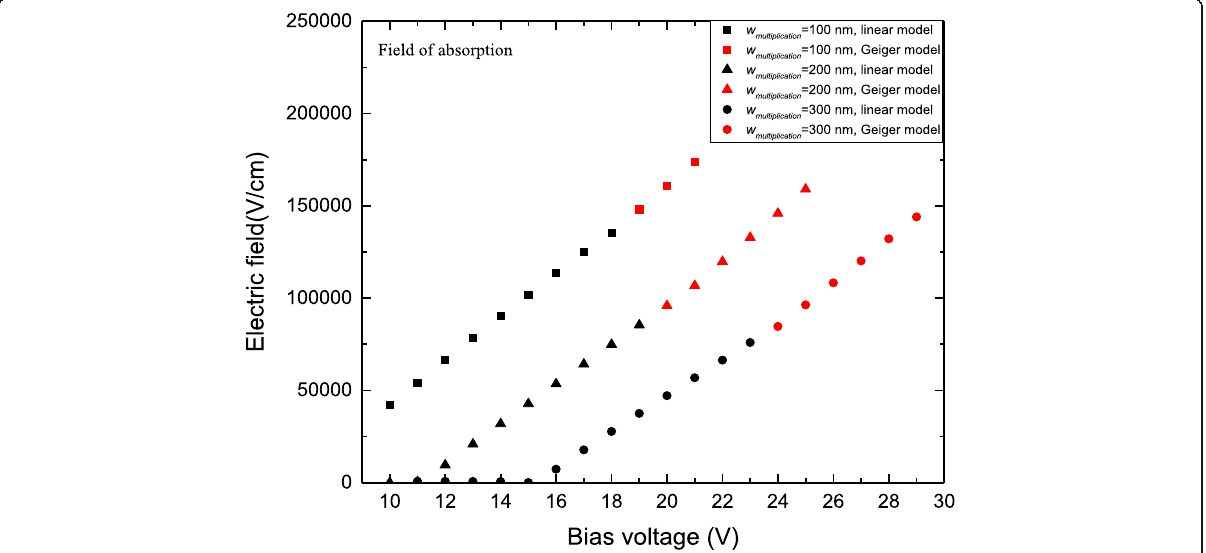
Fig. 5 Simulation results electric field in absorption under the Geiger mode. The values of W multiplication is 100 nm (black square), 200 nm (black triangle), 300 nm (black circle). Figure 4 presents the simulated field-voltage characteristics in the absorption layers under the Geiger mode. The thickness of the charge layer is 50 nm, and the thicknesses of the multiplication layer are 100, 200, and 300 nm,